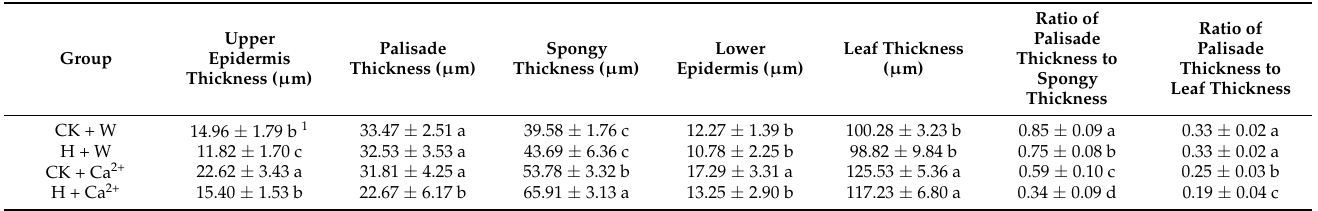
Figure 2. Leaf anatomical structure of Rhododendron × pulchrum leaves under four treatments. ( A ) CK + W represents the control treatment with distilled water; ( B ) H + W represents the heat stress treatment with distilled water; ( C ) CK + Ca 2+ represents the control treatment with 10 mM CaCl 2 ; ( D ) H + Ca 2+ represents the heat stress treatment with 10 mM CaCl 2 . L = lower epidermis; PT = palisade tissue; ST = spongy tissue; and U = upper epidermis. Table 1. Leaf anatomical structure of Rhododendron × pulchrum leaves under the four treatments.